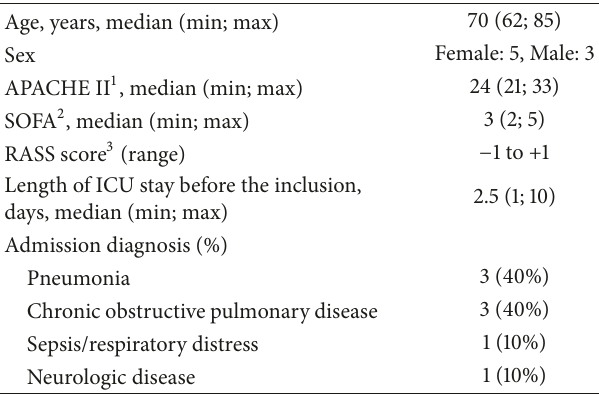
Table 1: Patient baseline characteristics, 𝑛 = 8 .